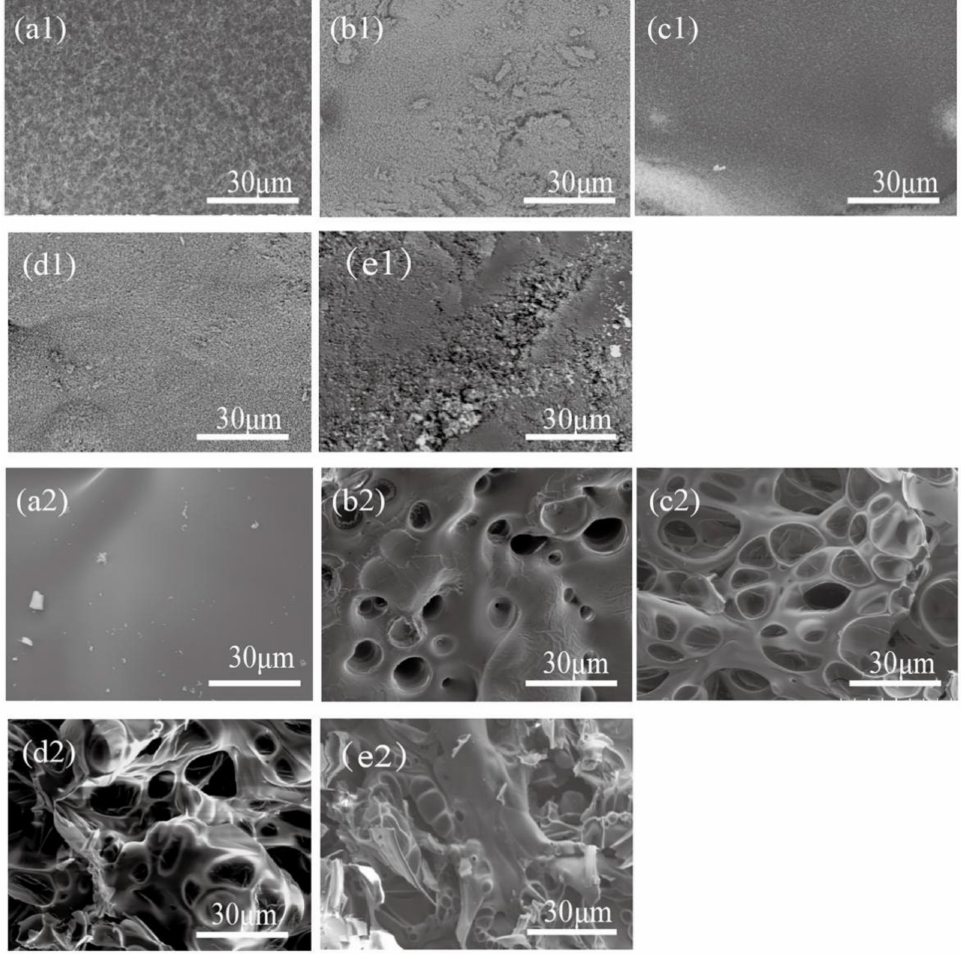
Figure 9. SEM of carbon residue: ( a1 , a2 ) EP, ( b1 , b2 ) EP/PolyTi1, ( c1 , c2 ) EP/PolyTi2, ( d1 , d2 ) EP/PolyTi3, ( e1 , e2 ) EP/PolyC. Outer layer: ( a1 – e1) and inner layer: ( a2 – e2